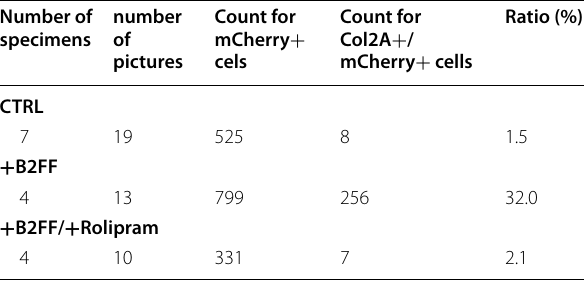
Table 2 The cell count of Col2a1 + mCherry + cells in newt-cell grafted axolotl limbs Number of number specimens of